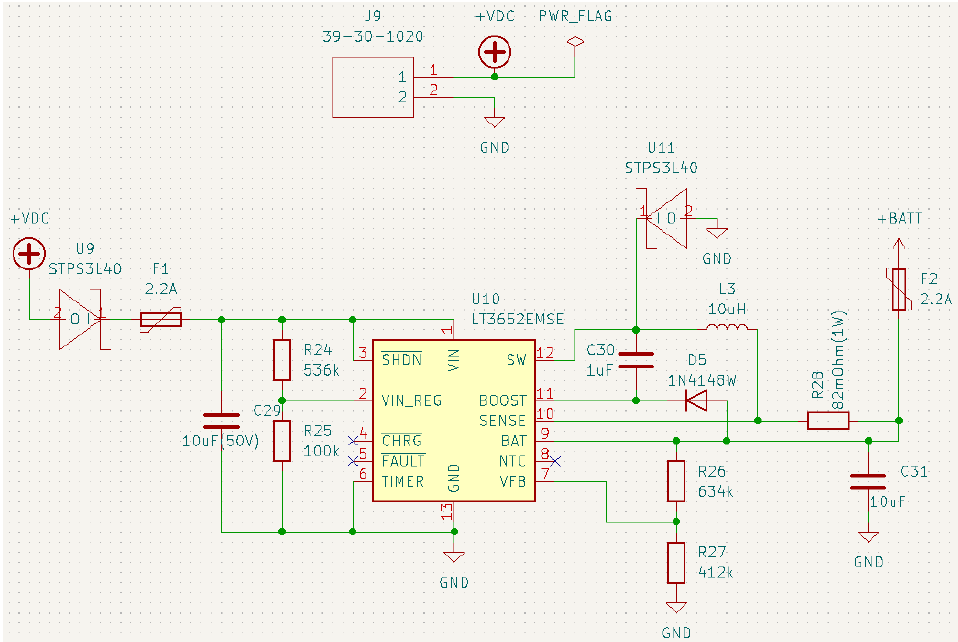
Figure 13. Solar power charger circuit.